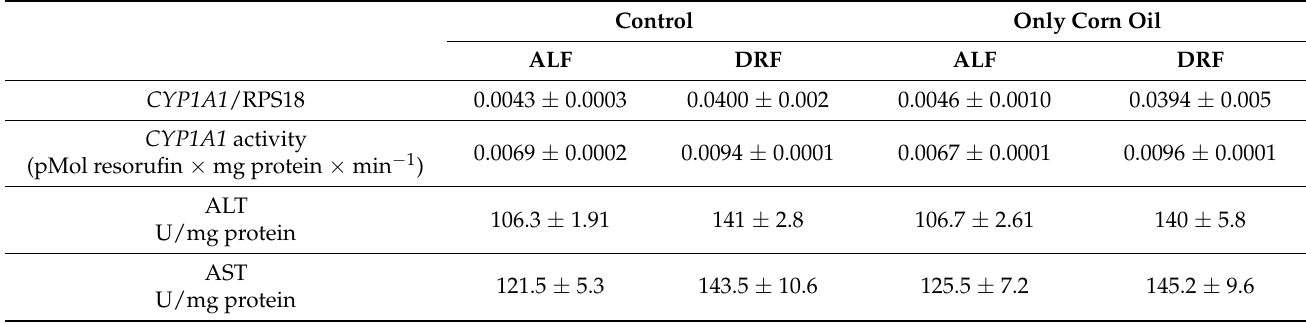
Table 3 . Effect of vehicle (corn oil) administrated i.p. in rats during ALF or DRF protocol on the expression/activity of CYP1A1 , and transaminase serum activities.